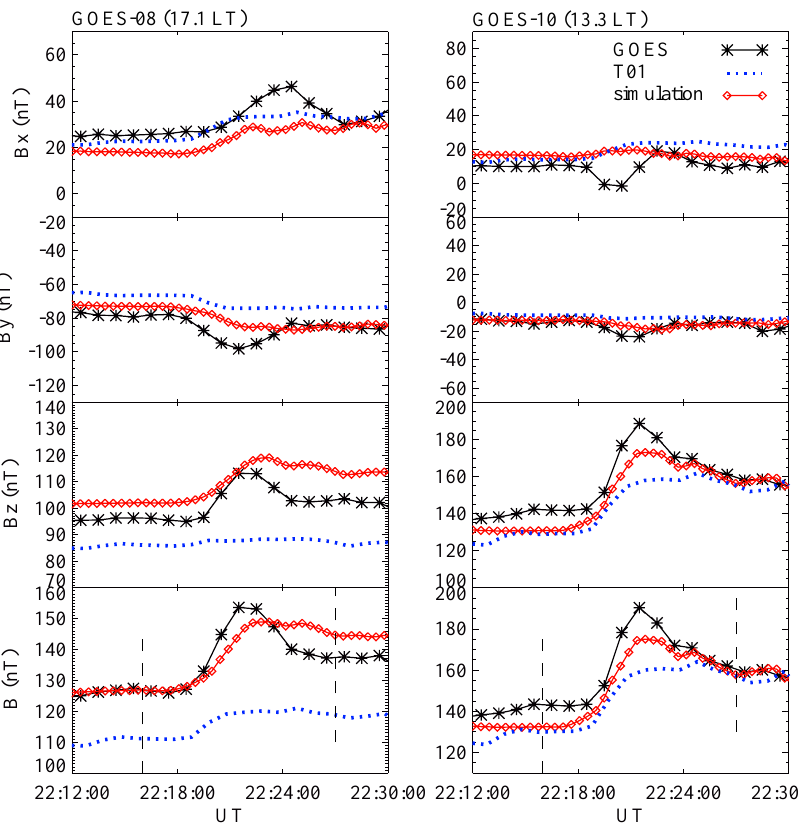
Fig. 2. Magnetic field at GOES-08 (left) and -10 (right) for the 14 August 2000 event. The stars denote the magnetic field observed by GOES, and the blue dotted lines are predicted by T01 model. Simulation results are shown by the red diamonds. The vertical dashed lines in the fourth panels show the time interval chosen to do the quantitative analyses.